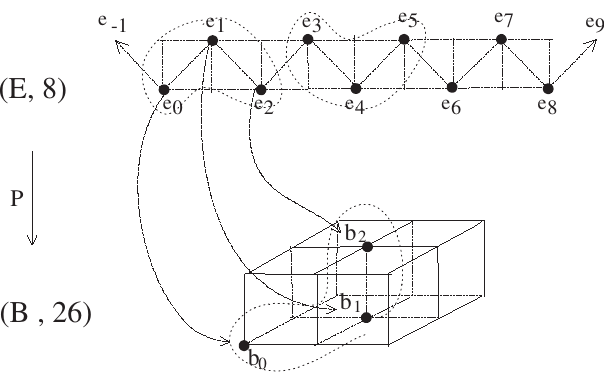
Figure 5. Configuration of an ( 8,26 ) -continuous surjection which is not a local ( 8,26 ) -isomorphism referred to in (18), where E is a portion of an infinite set (or an infinite fence set with 8-adjacency) in